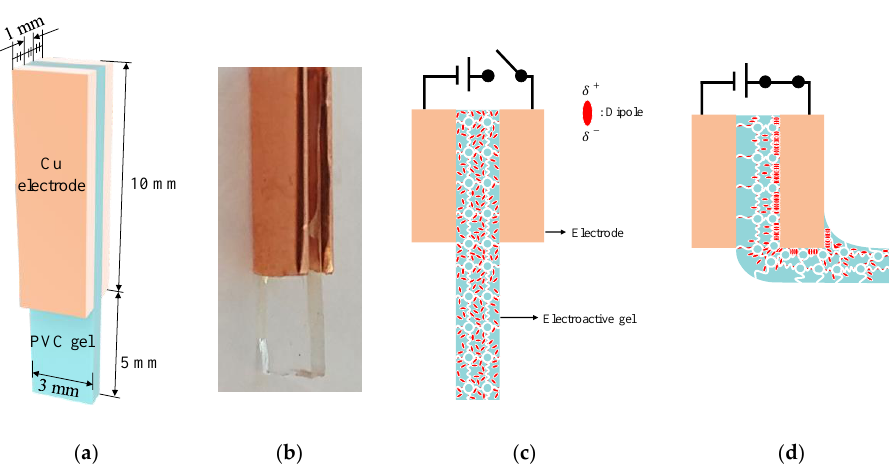
Figure 2. Structure and operating principle of the PVC gel-based bending actuator: ( a ) Structure of the proposed bending actuator, ( b ) fabricated bending actuator, ( c ) voltage-off state, and ( d ) voltage-on state.